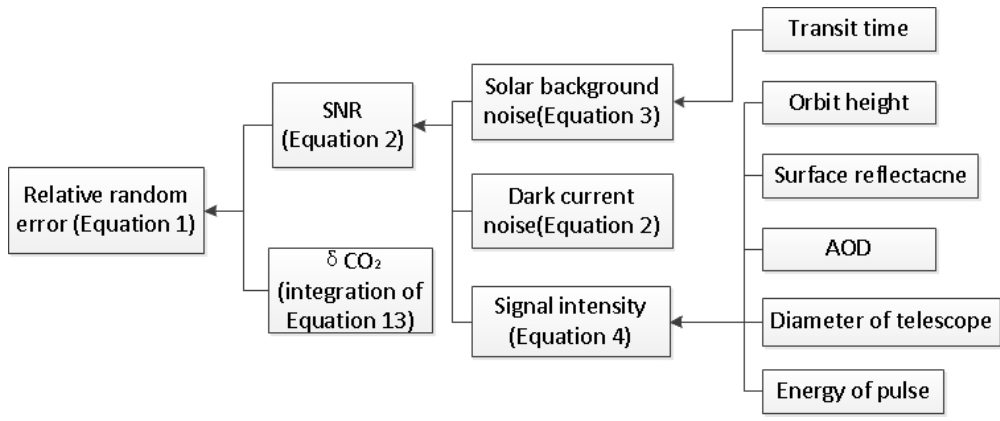
Figure 2. Schematic diagram for the estimation of random errors.